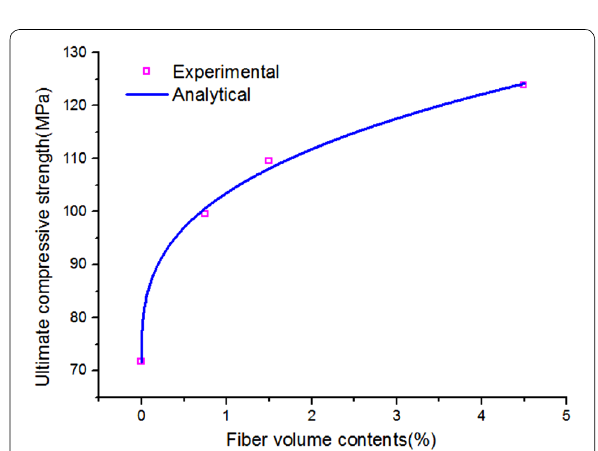
Fig. 16 Ultimate compressive strength-fiber volume contents